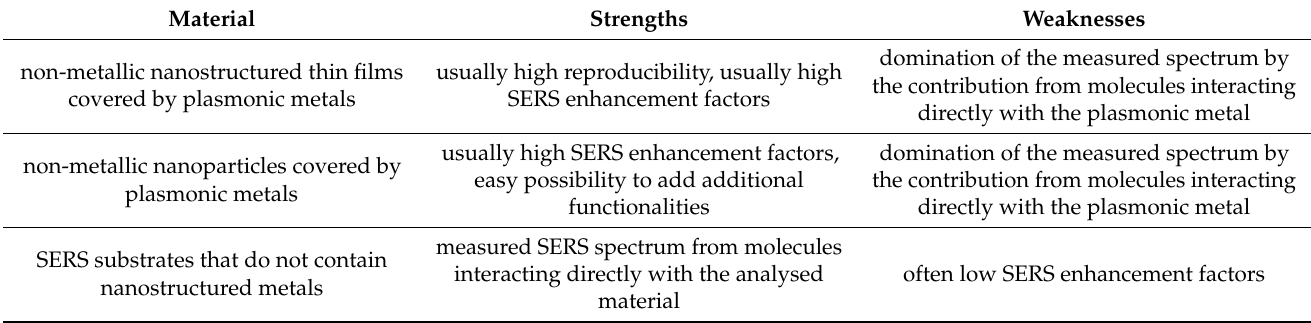
Table 2. Comparison of different types of SERS substrates formed from nanostructured non-metallic materials.